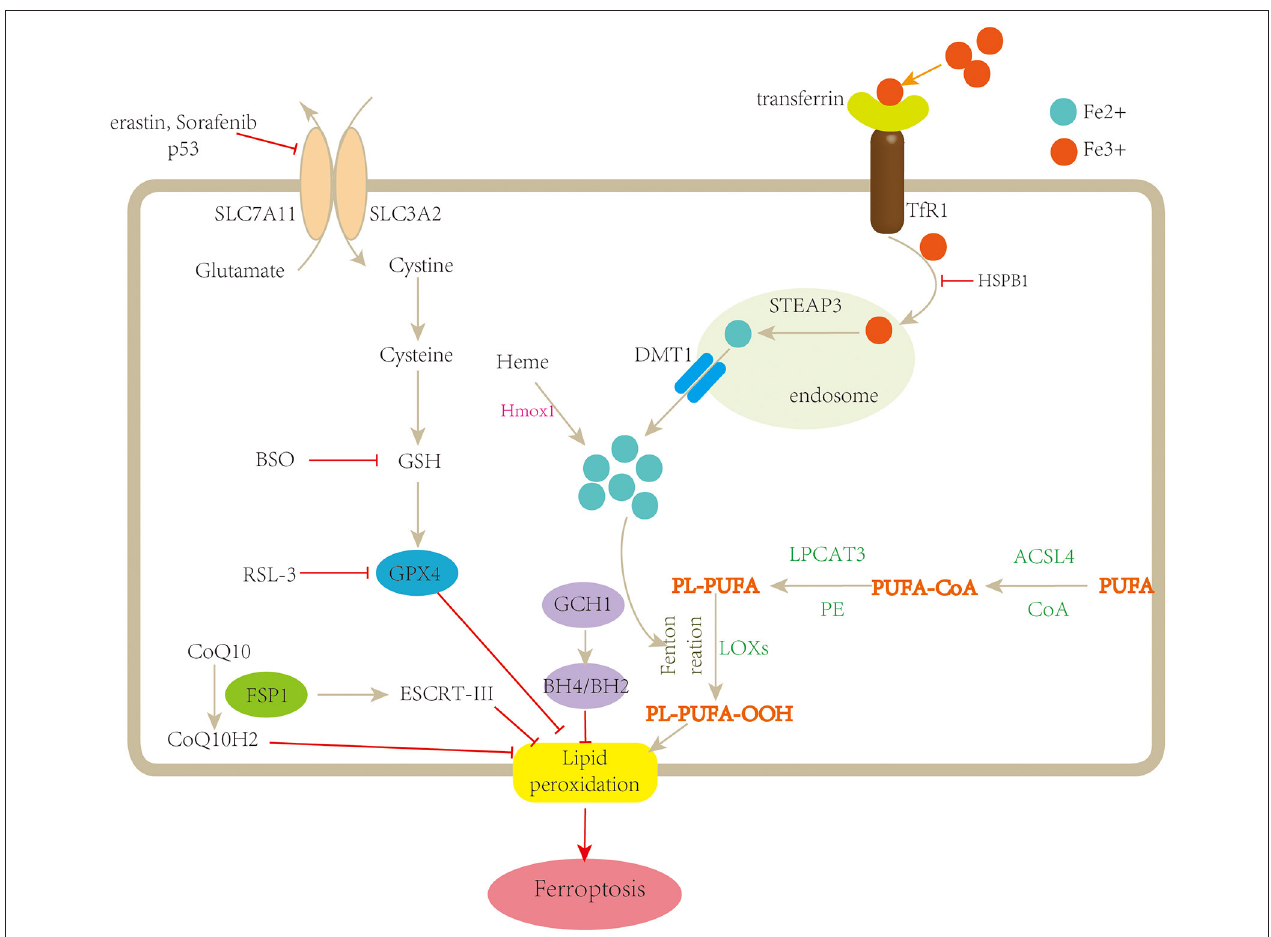
FIGURE 1 | Schematic description of the mechanisms of ferroptosis. Ferroptosis is a type of regulated cell death characterized by iron overload and lipid peroxidation. Fe 3 + is transferred into the cell by TfR1, then converted to Fe 2 + in the endosome, and released from the endosome by divalent metal transporter 1 (DMT1). Fenton reaction promotes lipid peroxidation by activating lipoxygenases (LOXs). Cystine is uptaken by system xc − for the synthesis of GSH, which further enhances the anti-lipid peroxidation activity of GPX4. In addition, FSP1-CoQ10 and GCH1-BH4/BH2 are two parallel GPX4-independent pathways in the suppression of ferroptosis. TfR1, transferrin receptor 1; STEAP3, STEAP family member 3; Hmox1, heme oxygenase-1; BSO, buthionine sulfoximine; PUFA, polyunsaturated fatty acid; CoA, coenzyme A; PL, lysophosphatide; ACSL4, acyl-CoA synthetase long-chain family member 4; LPCAT3, lysophosphatidylcholine acyltransferase 3;